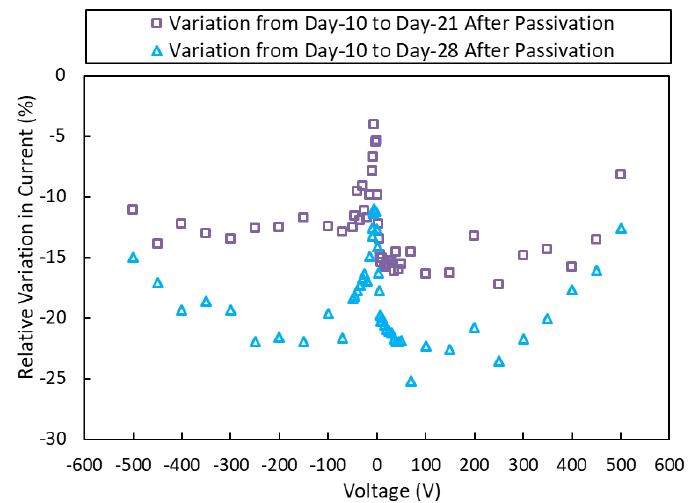
Figure 4. Relative variations in currents for days 10–21 and days 10–28 after passivation. These show a continuous decrease from day 10.